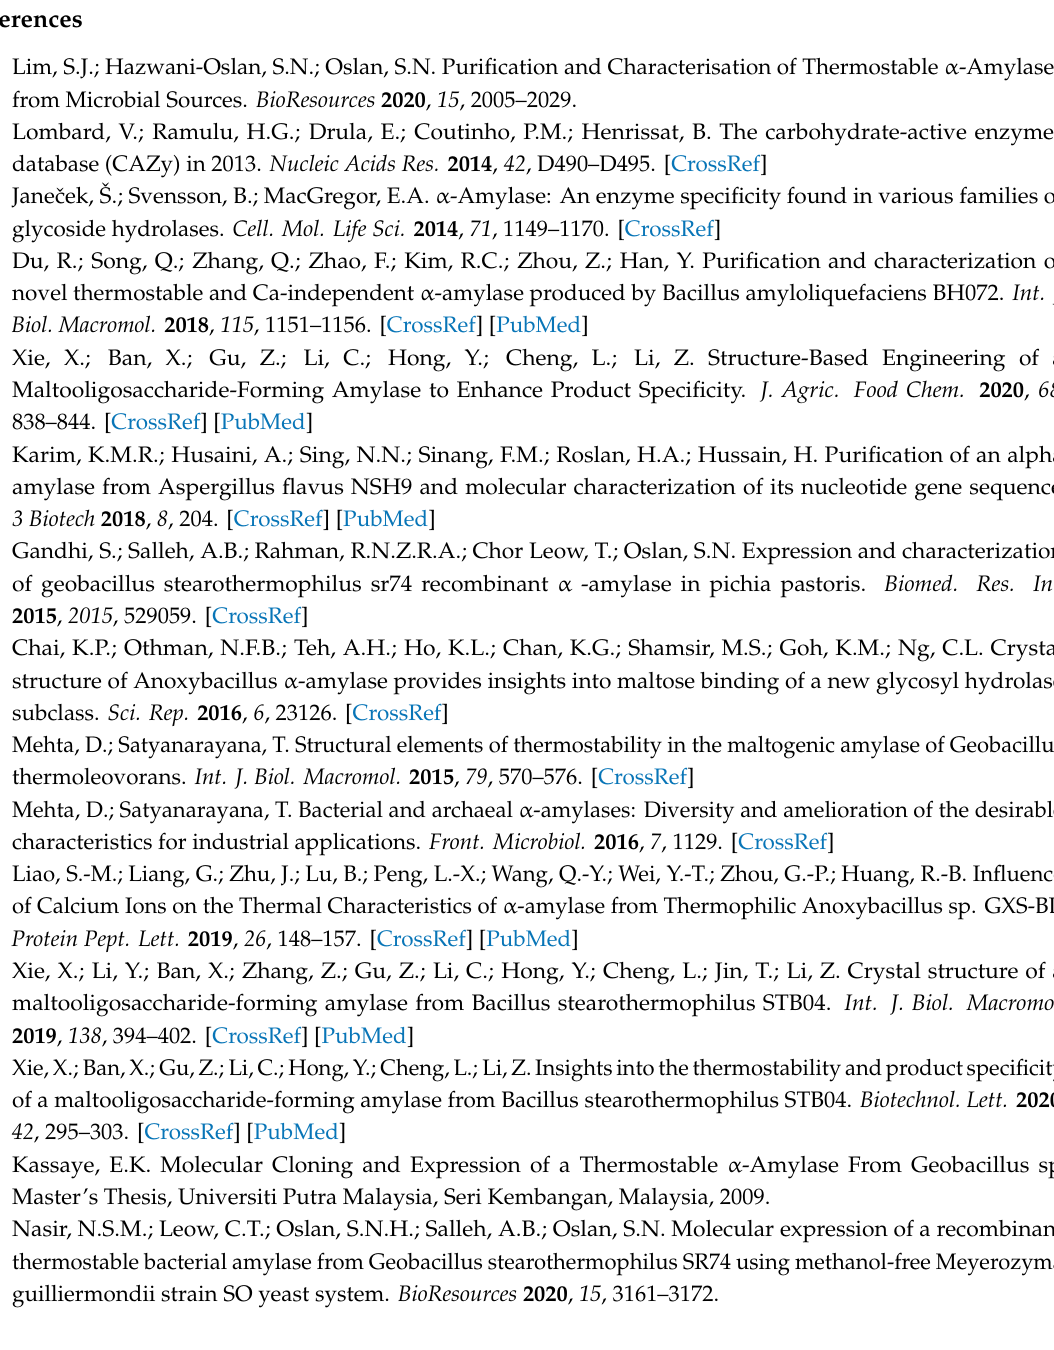
Figure S1: Secondary structure map of WT and rc SR74 α -amylases, Figure S2: Multiple sequence alignment (MSA) of the template 6ag0.1.A, WT and rc SR74 α -amylases, Table S1: Multiple sequence alignment (MSA) of the BLASTP results, Table S2: Validation of SR74 α -amylases 3D structures using Verify3D, ERRAT and PROCHECK, Table S3: Pairwise RMSD within template 6ag0.1.A, WT and rc SR74 α